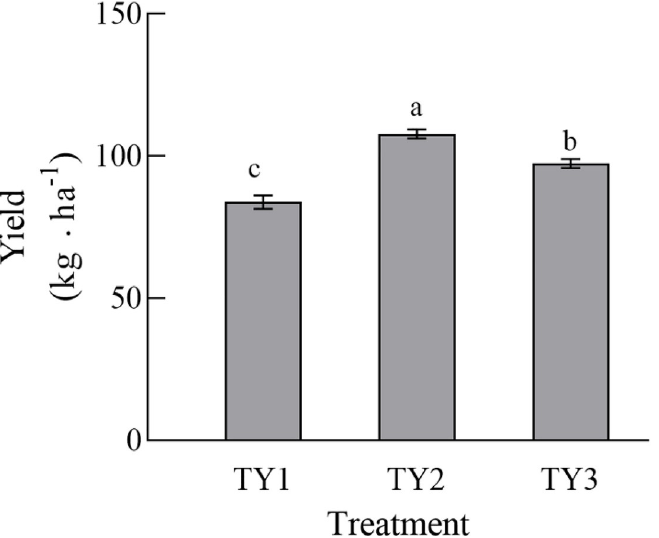
Fig 6. Comparison of tomato yields between different planting patterns. Different lowercase letters in the same panel indicate significant differences at the 0.05 level. In each planting method group, bar charts labelled by different letters are significantly different according to a one-way analysis of variance (ANOVA) (P < 0.05) and Duncan’s Multiple Range Test (DMRT) (P < 0.05). TY1, Tomato continuous cropping; TY2, Eggplant-tomato rotation; TY3, Arrowhead-tomato